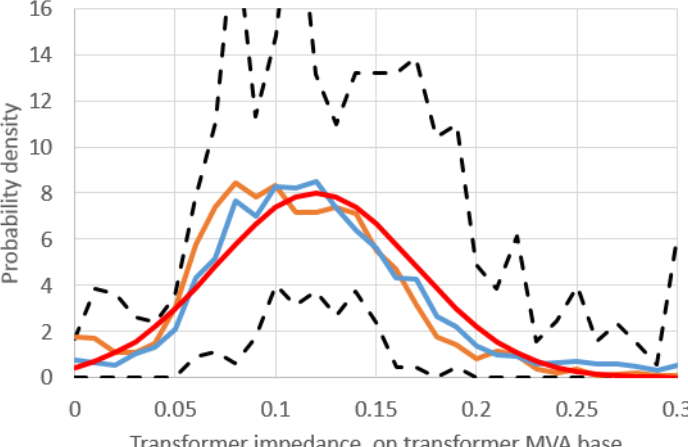
Figure 6. Probability density of transformer reactance, for EI (blue), WECC (orange), and envelope of 12 subset cases (black), and normal fit (red).